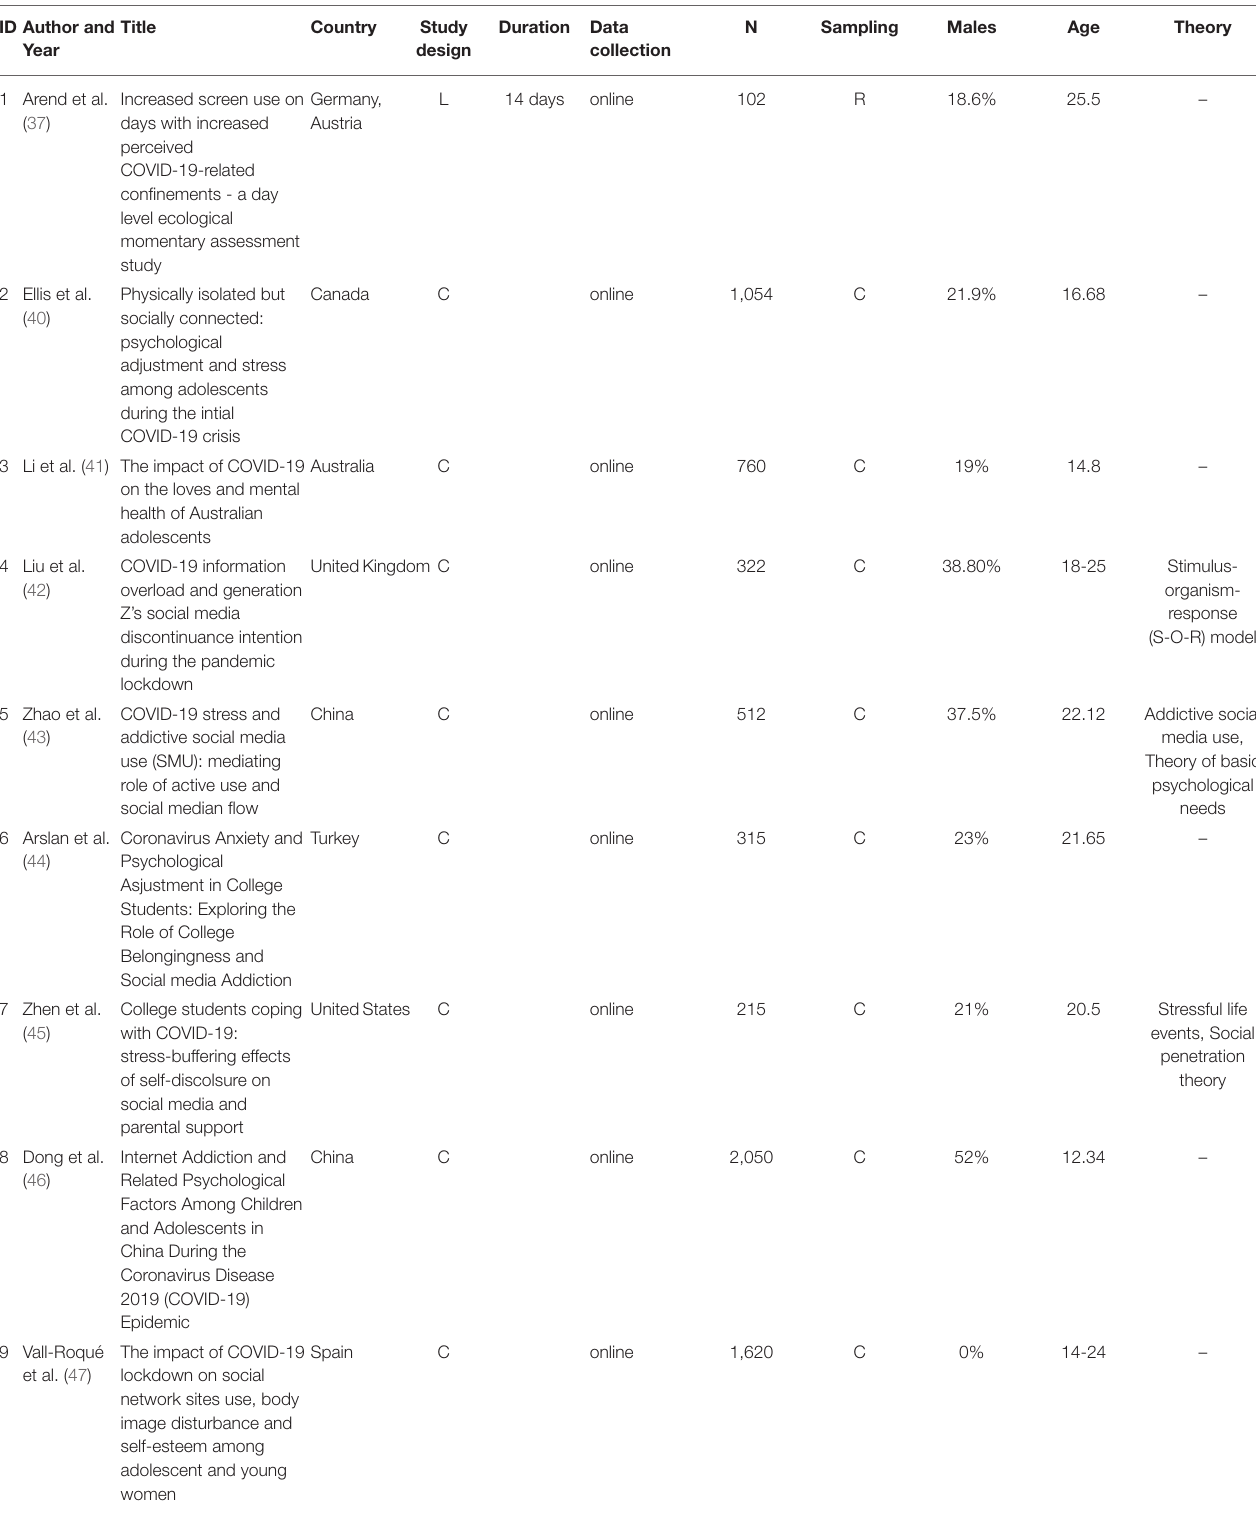
TABLE 4 | Summary of the included